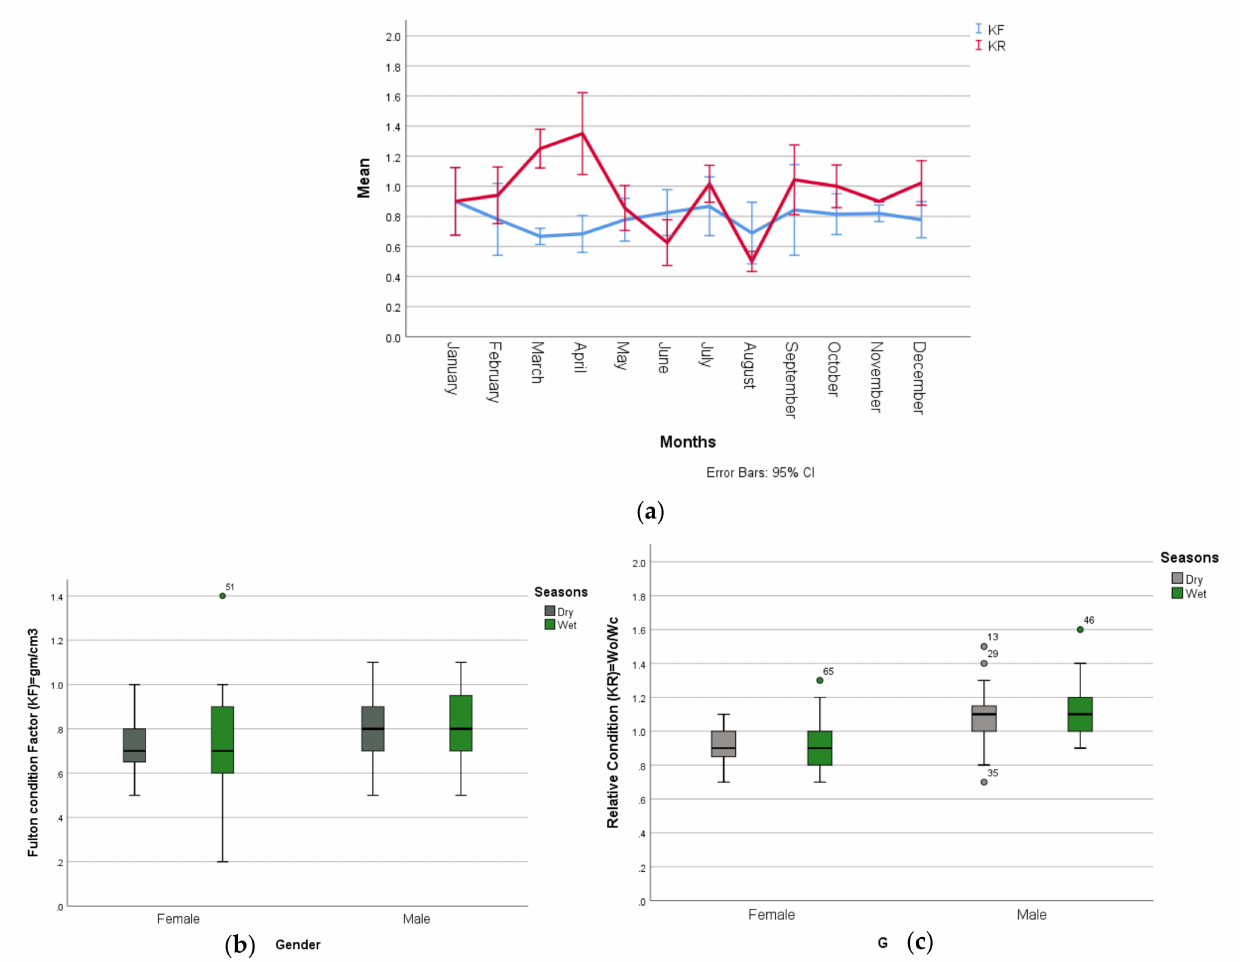
Figure 4. The variation of Fulton condition factor and realative condition factor in different ( a ) months and ( b , c ) seasons in adult Chinese